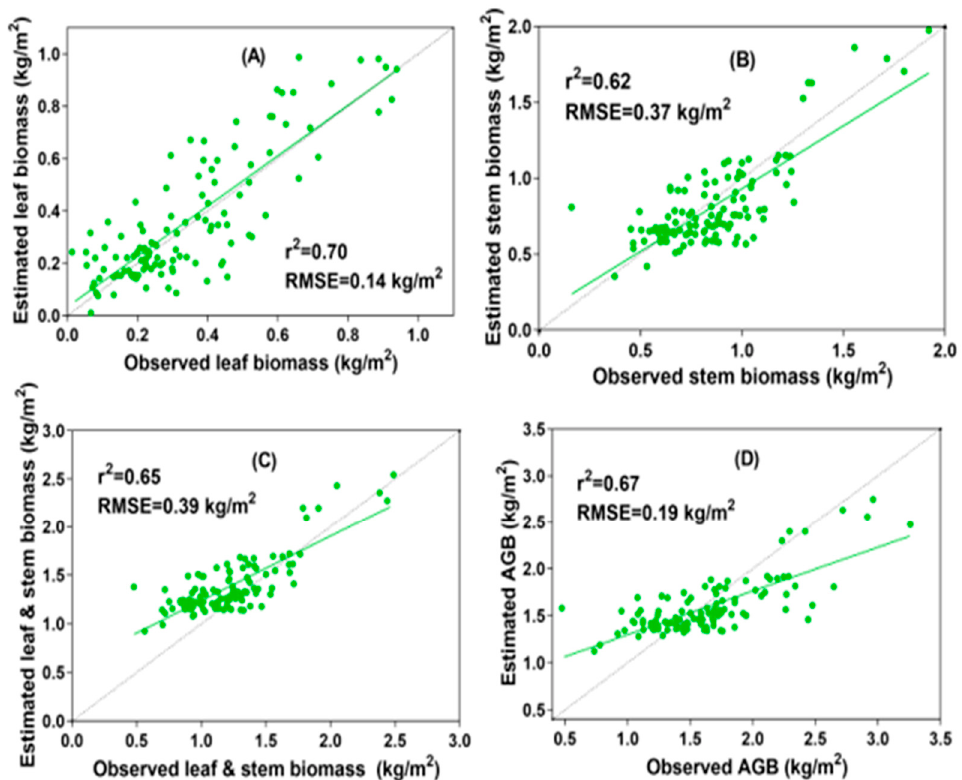
Figure 4. Comparisons between measured and estimated biomass components from multi-target Gaussian regressor stacking (MGPRS) using RDVI1 and SND (cid:2906)(cid:2892) VH biomass, ( C ) leaf and stem biomass, and ( D ) AGB. The green line represents a linear regression between the observed and estimated values and the dashed line represents the 1:1 line.